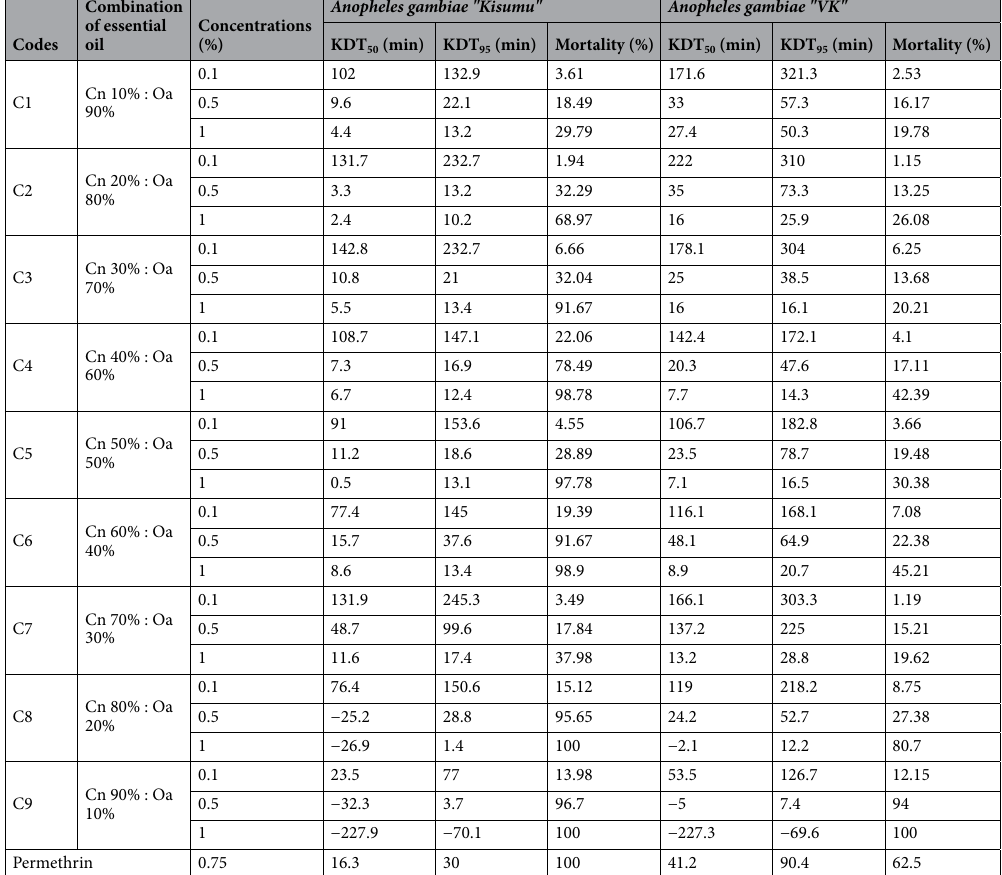
Table 5. KDT50, KDT95 and rates of mortality of essential oils combinations of C. nardus (C.n) and O. americanum (O.a) tested on the susceptibility (Kisumu) and field (VK) strains of Anopheles gambiae populations. KDT 50 : 50% of mosquitoes knock down time; KDT 95 : 95% of mosquitoes knock down time; VK: Vallée du Kou; % : percentage; min : minutes; Cn : Cymbopogon nardus ; Oa : Ocimum americanum.